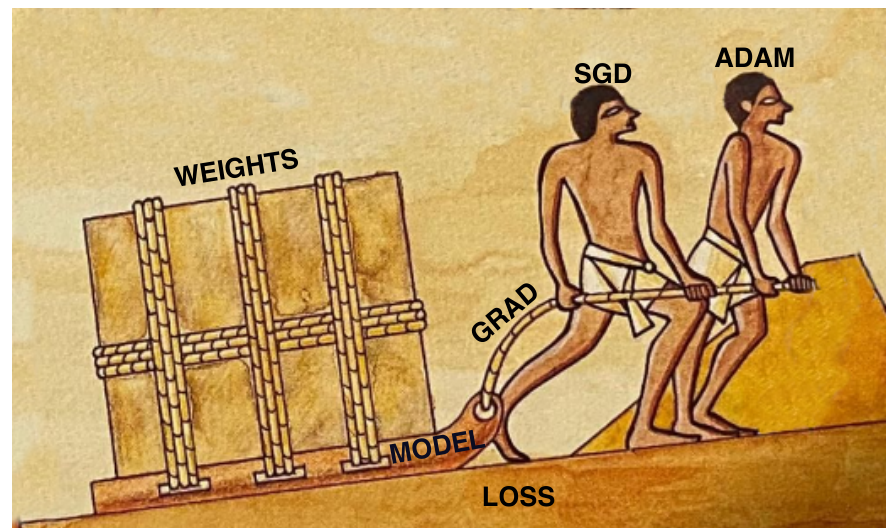
Figure 1. Intuitive representation of the idea behind the proposed ATMO that Mix ADAM and SGD optimizers: the weights are modified simultaneously by both the optimizers.